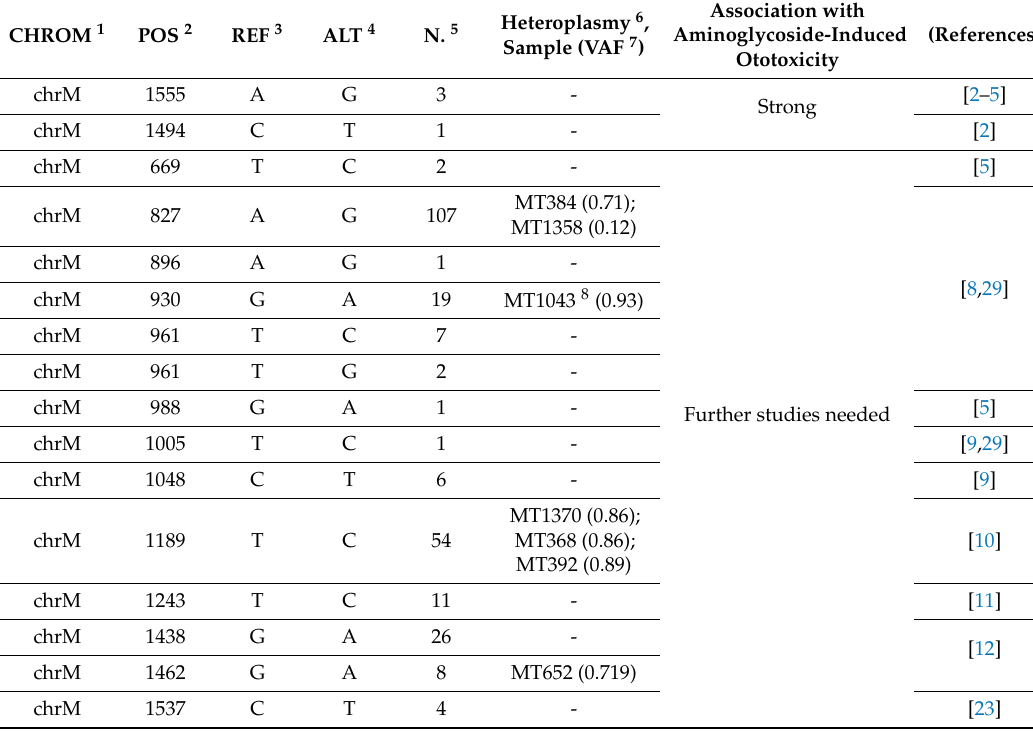
Table 2. MT-RNR1 variants related with aminoglycoside ototoxicity found in 1245 clinical whole-exome sequencing (WES)